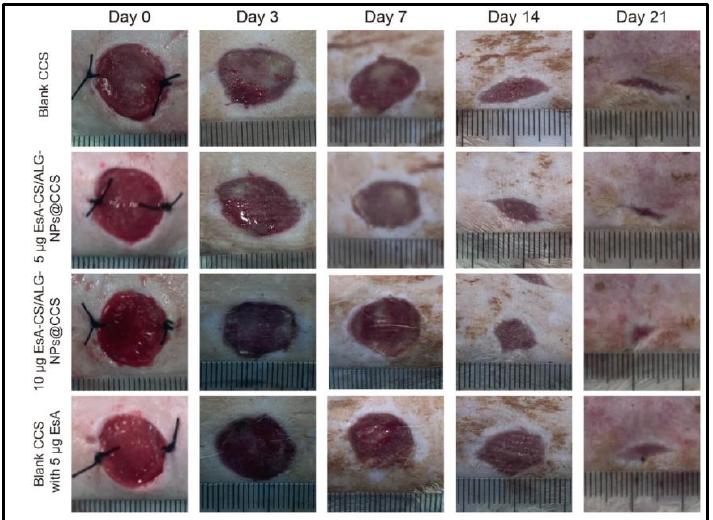
Figure 8. Images of the healing of burn wounds after transplantation with the blank Collagen/chitosan scaffold, 5 µg drug–chitosan/alginate nanoparticles @ collagen/chitosan scaffold, 10 µg drug-chitosan/alginate nanoparticles @collagen/chitosan scaffold, and blank collagen chitosan scaffold with 5 µ g drug at days 0, 3, 7, 14, and 21 (Reproduced with permission from [95]; Copyright 2023, American Chemical